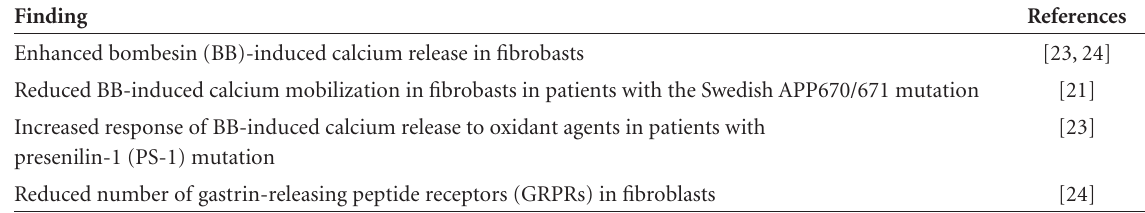
Table 2. Abnormalities in the gastrin-releasing peptide receptor (GRPR) pathway in patients with Alzheimer’s disease (AD).